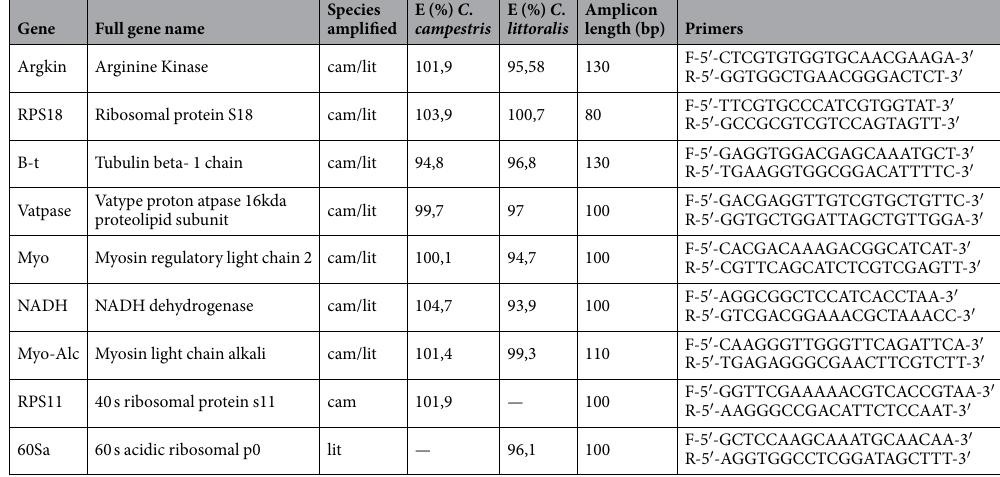
Table 1. Primers used for qRT-PCR experiments for both C . campestris (cam) and C . littoralis (lit). E = amplification